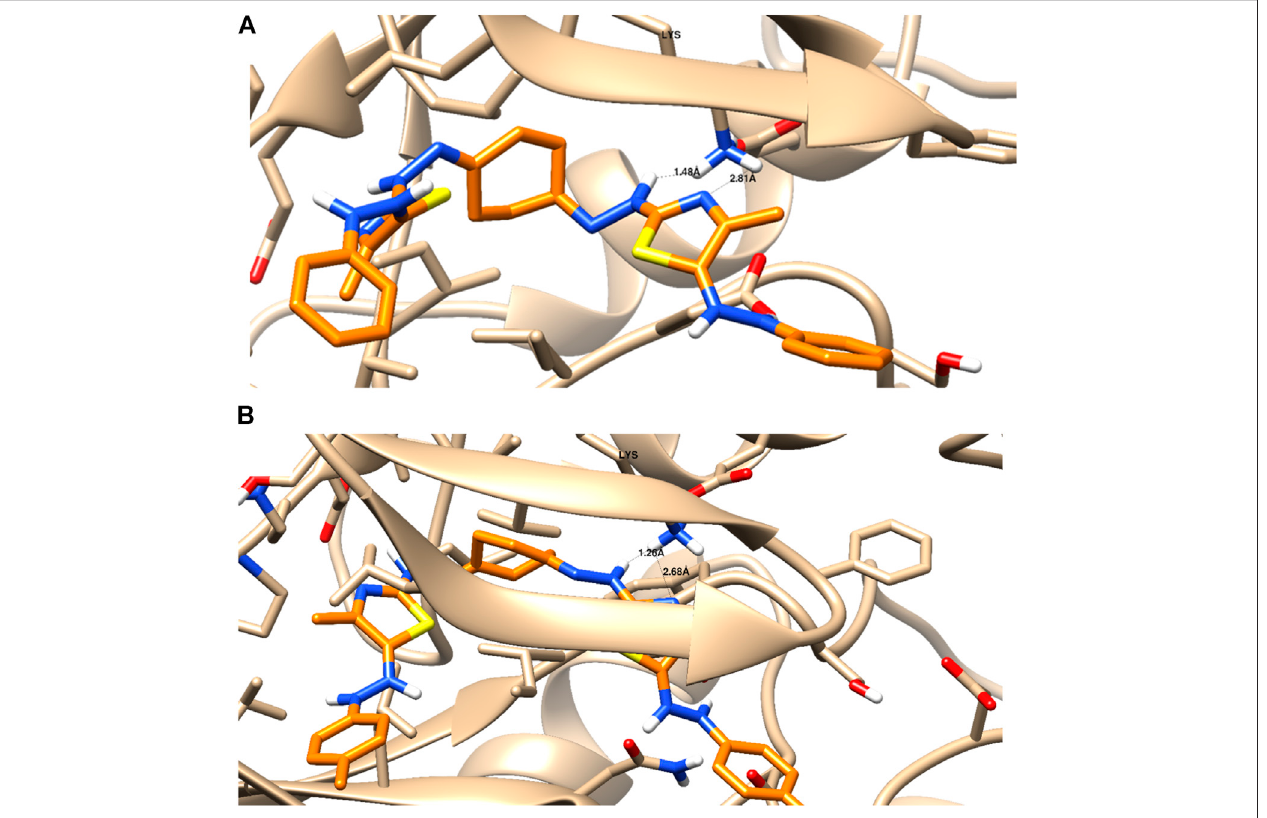
FIGURE 4 | Binding disposition and interaction analysis of the docked compounds 5a (A) and 5b (B) , inside the Pim-1 kinase protein.